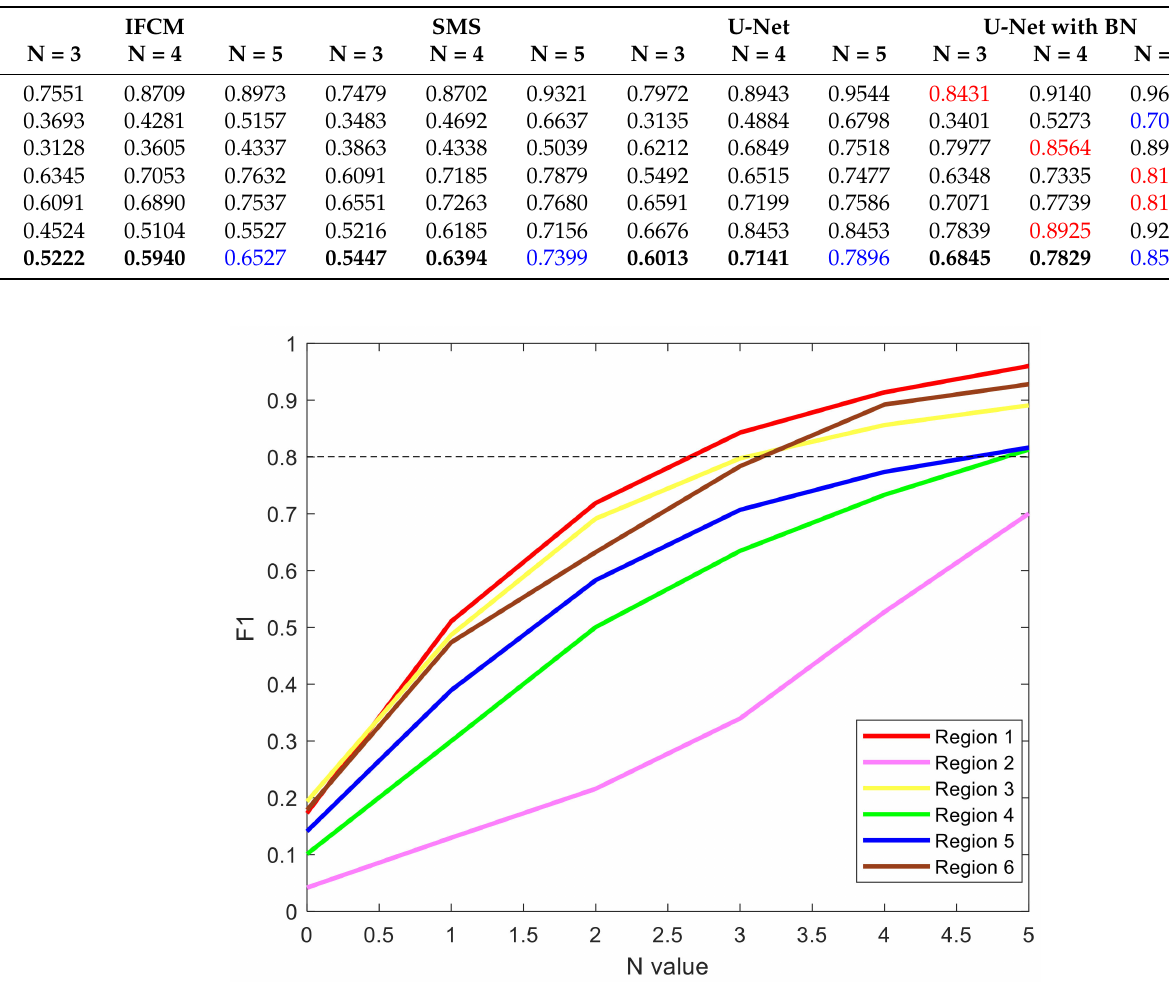
Figure 8. F1-measure of six regions by comparing the proposed method with the ground truth